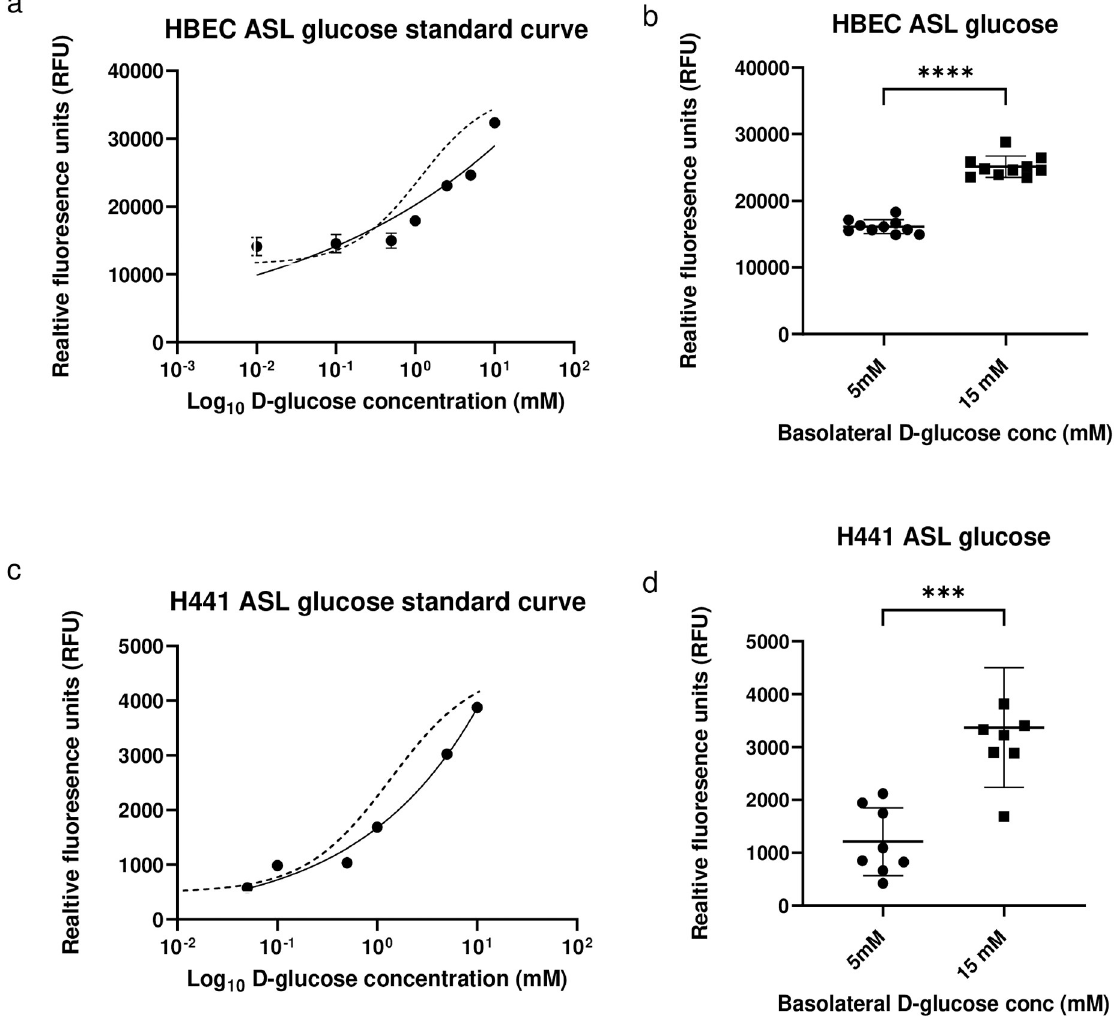
Fig 5. Fluorescence of E149C/A213R GBP-IANBD applied to the ASL of HBEC or H441 grown at air-liquid-interface together with known concentrations of glucose to obtain a concentration effect curve a. and c. The response curve measured in PBS over the same glucose concentration range is shown as a dotted line in both graphs. Fluorescence of E149C/A213R GBP-IANBD applied to the ASL of HBEC or H441 without added glucose to measure changes in ASL glucose when basolateral glucose concentration was raised from 5mM to 15 mM D-glucose in the basolateral chamber for 10 minutes b. and d. Data are shown as mean ± SD. Significantly different �� p < 0.001, ���� p < 0.0001.